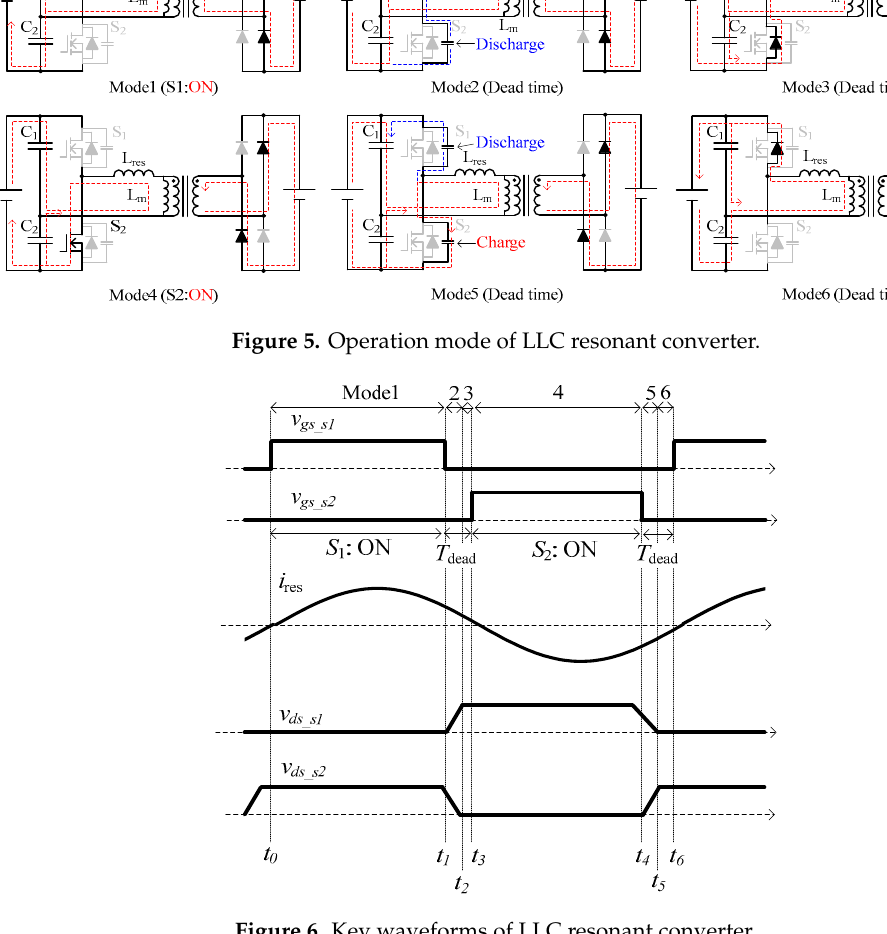
Figure 6. Key waveforms of LLC resonant converter.